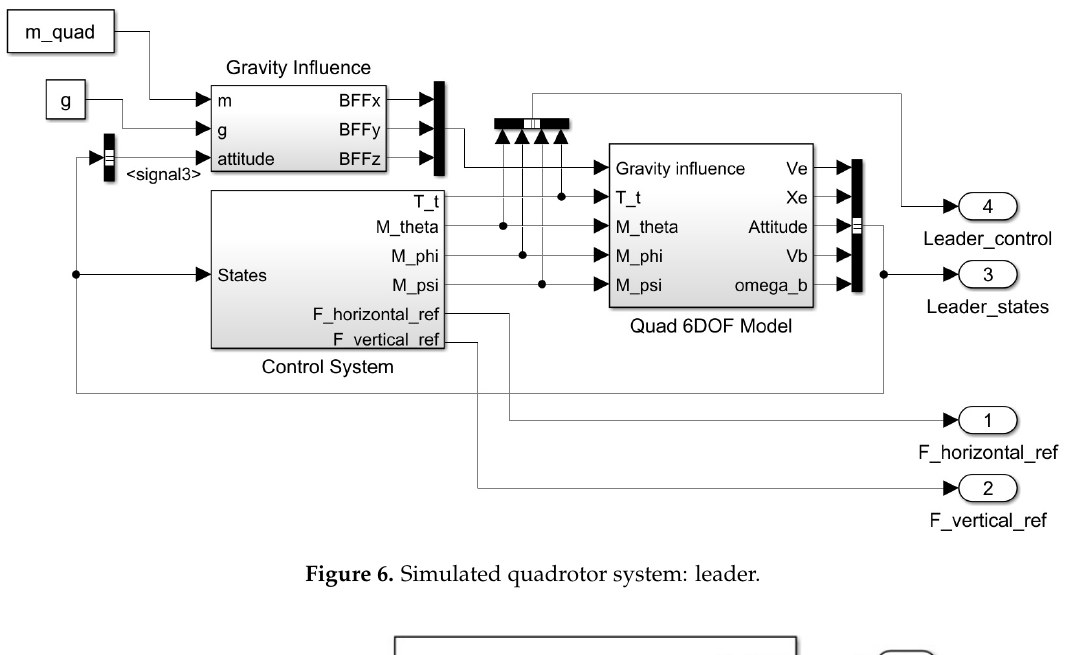
Figure 6. Simulated quadrotor system: leader.